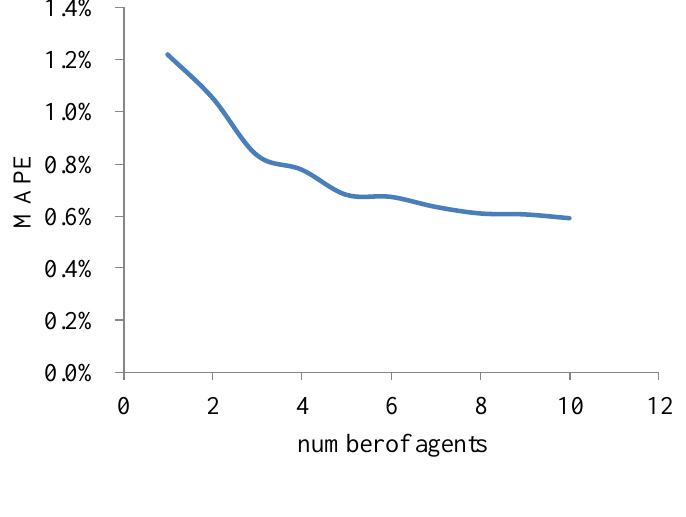
Figure 3. The accuracy of the agent-based fuzzy collaborative intelligence